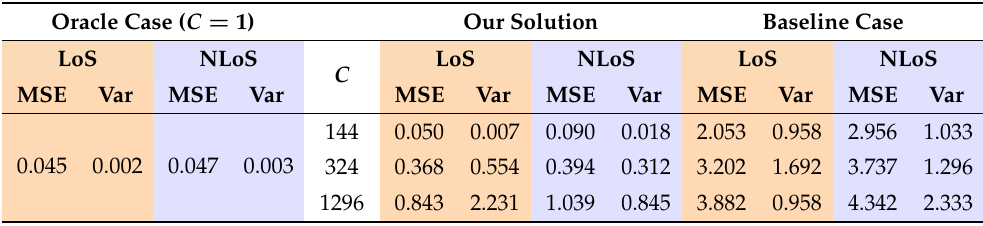
Table 3. The localization errors ( m ) of LoS (orange) and NLoS (blue) areas for the oracle/baseline C = 144/324/1296, A = 51.84, σ = 0 cases and our solution when { always equals to 1 for reference.